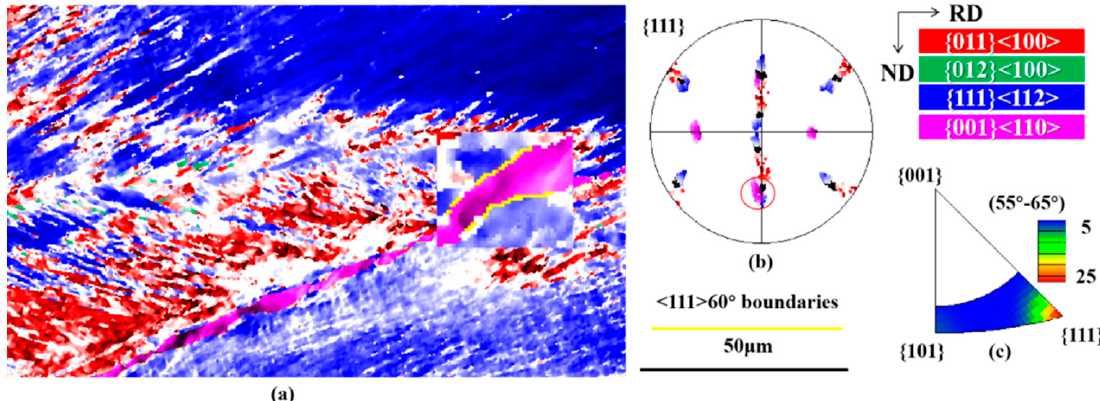
Figure 3. EBSD measurement of 0.075 mm sheet in transverse plane with step size=0.2 μ m: (a) EBSD orientation image mapping; (b) {111} pole figure; (c) rotation axes distribution for misorien- tation angle of 55–65 ˚ in (a).